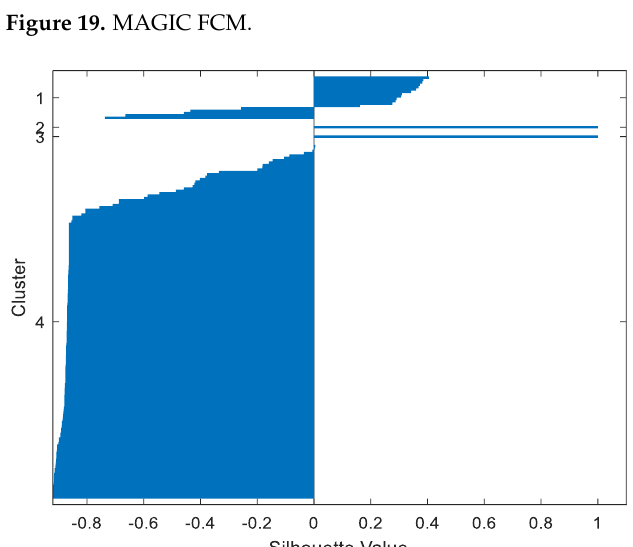
Figure 19. MAGIC FCM.